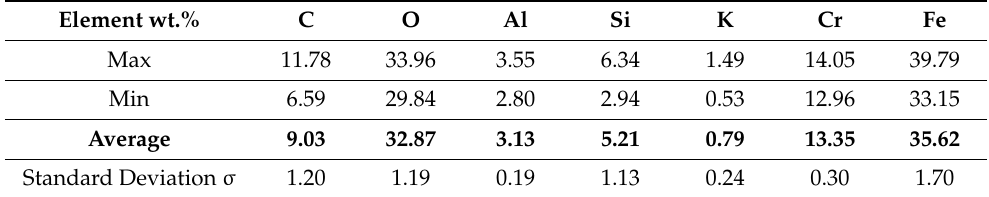
Table 8. Elemental wt.% contents of spent sand SS after roasting for 2 h at 1000 ◦ C in the analysed area (in Figure 16b).